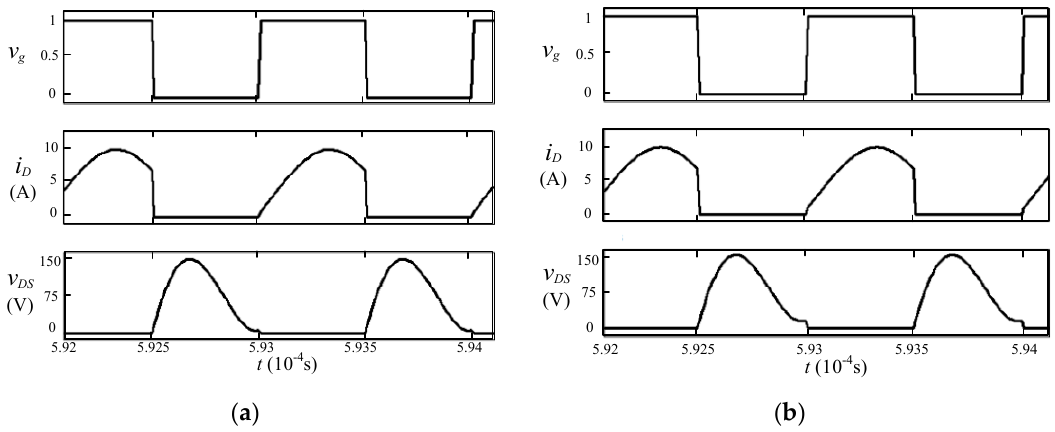
Figure 12. Switching states with various distance between the coils and iron plate. ( a ) d 3 = 15 cm; ( b ) d 3 = 5 cm.